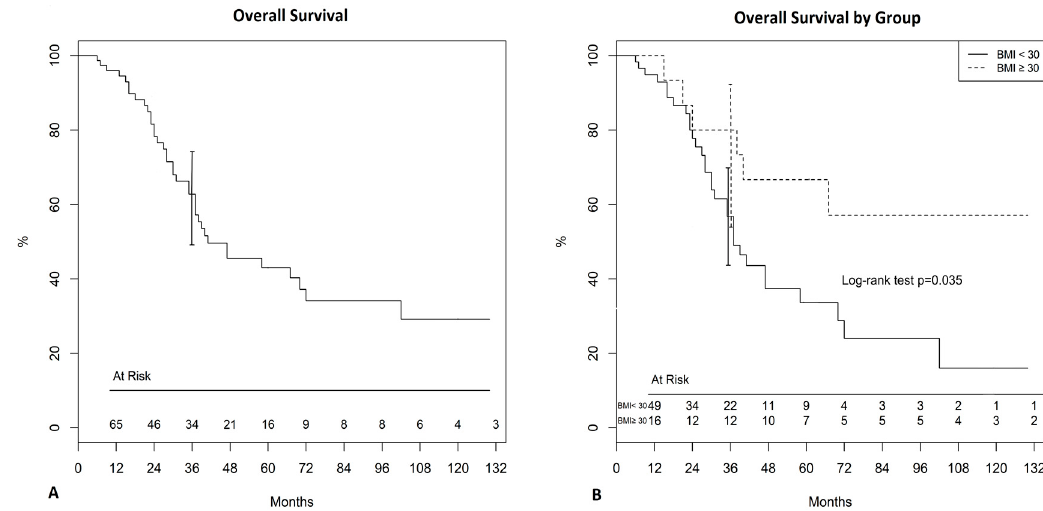
Figure 1. ( A ) Overall survival for the whole population. ( B ) Overall survival by group (obese, BMI > 30, and non-obese, BMI < 30).